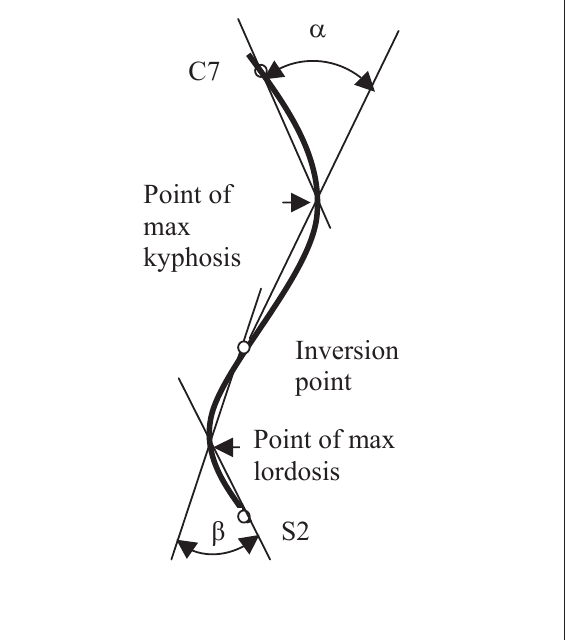
Figure 1. Assessment of thoracic kyphosis and lumbar